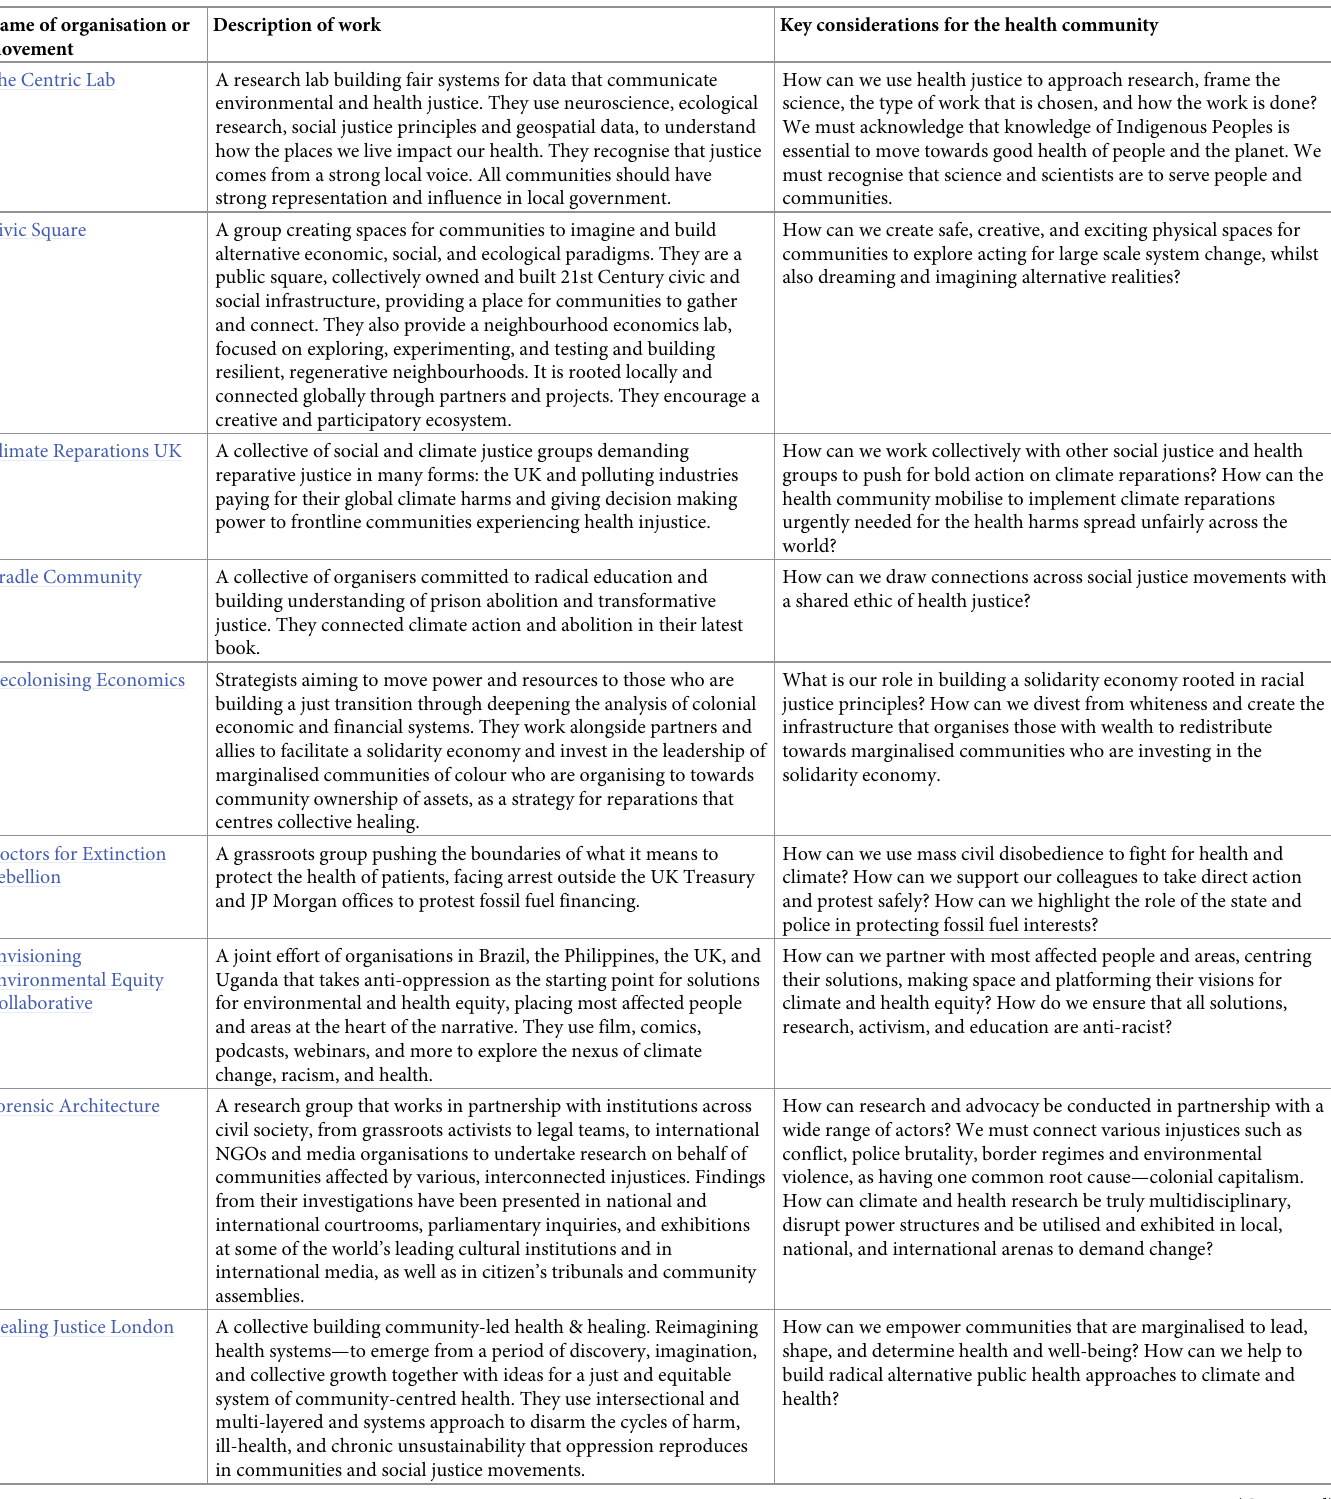
Table 1. Organisations and movements breaking free from tunnel vision within the climate change and/or health space (UK and international). Name of organisation or